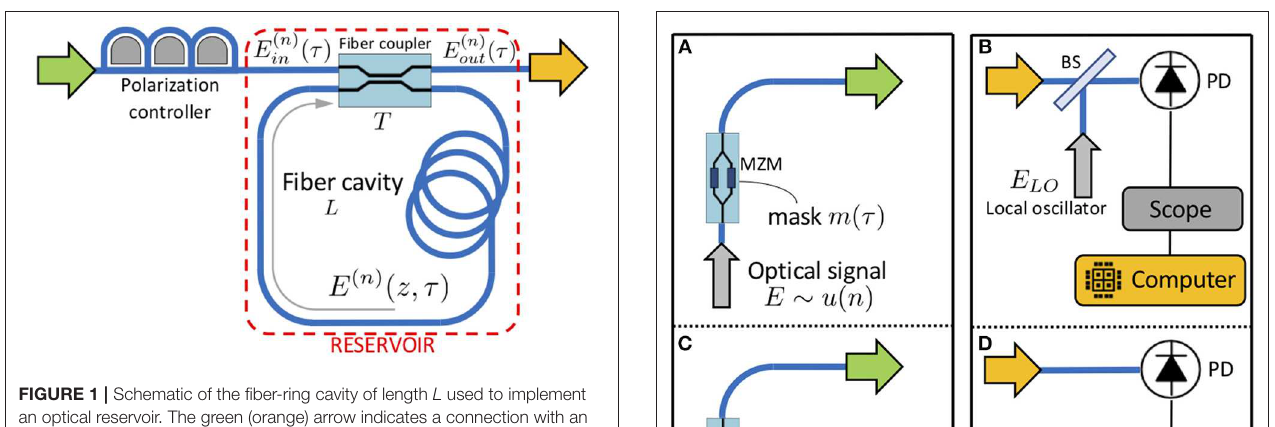
shown in Figure 1 . In the linear input scheme (A) the Mach-Zehnder modulator (MZM) superimposes the reservoir’s input mask m ( τ ) on the optical u ( n ) carrying the input data. In the (possibly) non-linear input signal E ∼ scheme (B) the input data is mixed with the input mask and then drives the MZM to modulate a CW optical pump. In the linear output scheme (C) a reference field E LO is used to implement coherent detection, allowing a quadrature of the complex optical field to be measured. Note that coherent detection requires two such readout arms with phase-shifted reference fields in order to measure the complex output field E out . In the non-linear output scheme (D) only a photodetector (PD) is used, thus only allowing the optical 2 to be E out output power | |